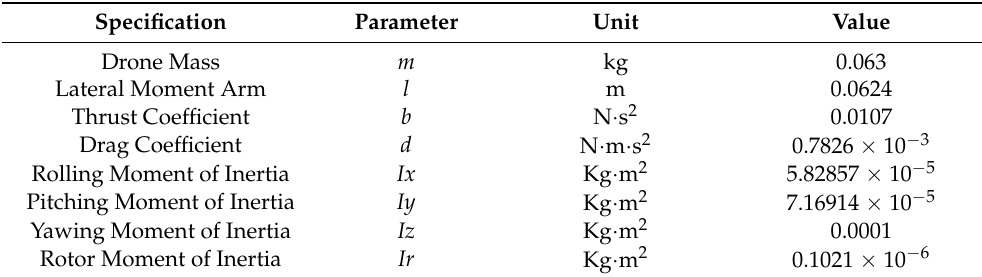
Table 2. The Parrot aerial robot model specifications